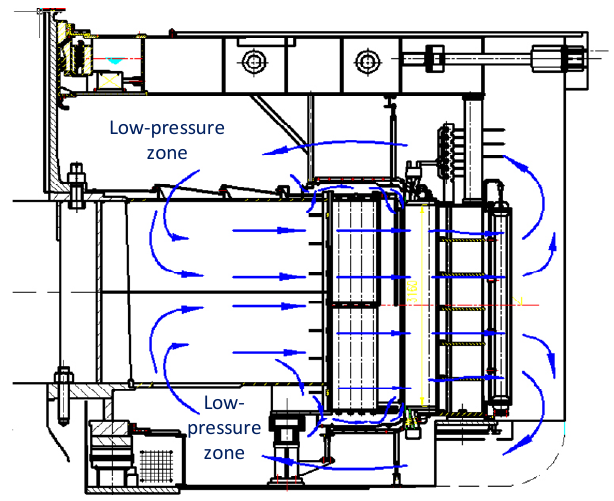
Figure 4. The blast path and low-pressure zone [55].